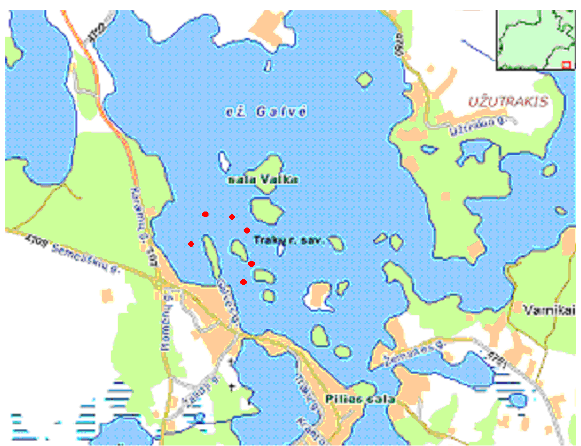
Fig. 2. Locations of perch and roach sampling in the Galvė lake, Trakai region, February